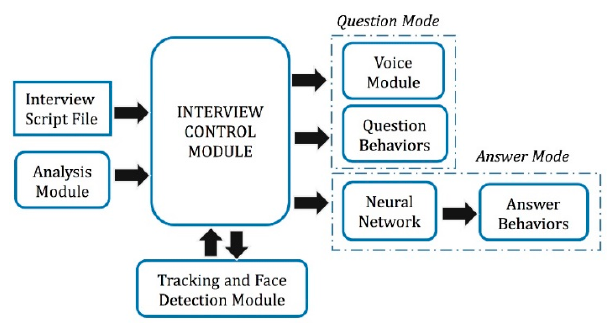
Figure 13. Interview control module.